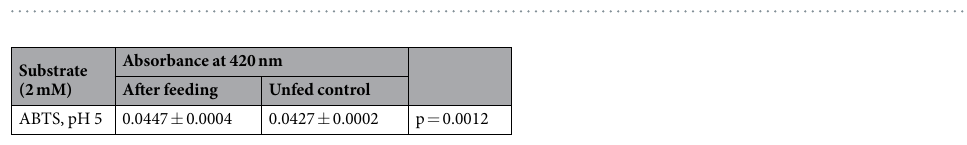
Figure 2. Temporal and spatial expression of B. tabaci LAC1 measured by real-time qPCR. ( A ) Expression in salivary gland (SG), midgut(Mg), ovary(Ov) and whole body (Wh). ( B ) Expression in female and male. ( C ) Expression in egg, larval and adult stages. Values are represented as the mean ± SEM. The letters above the columns indicate the comparison among groups evaluated, p < 0.05.